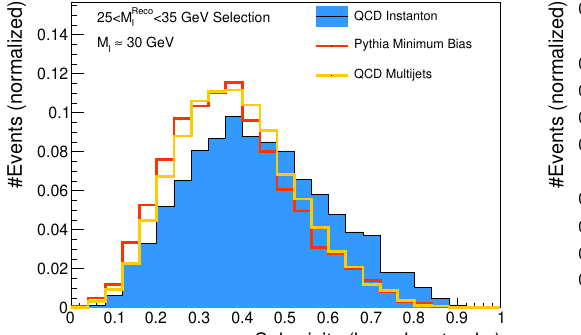
< I < 480 GeV (right). I